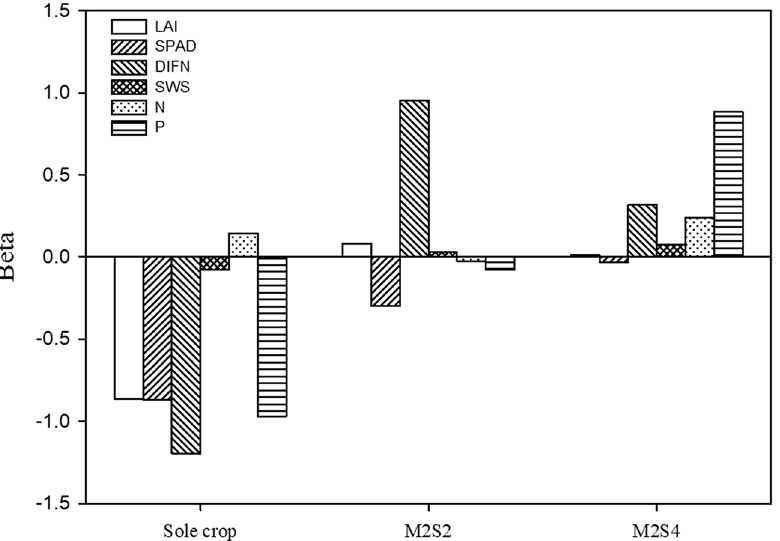
Figure 5. Contribution value of above- and below-ground interaction on the biological yield. M2S2, two rows of maize intercropped with two rows of soybean; M2S4, two rows of maize intercropped with four rows of